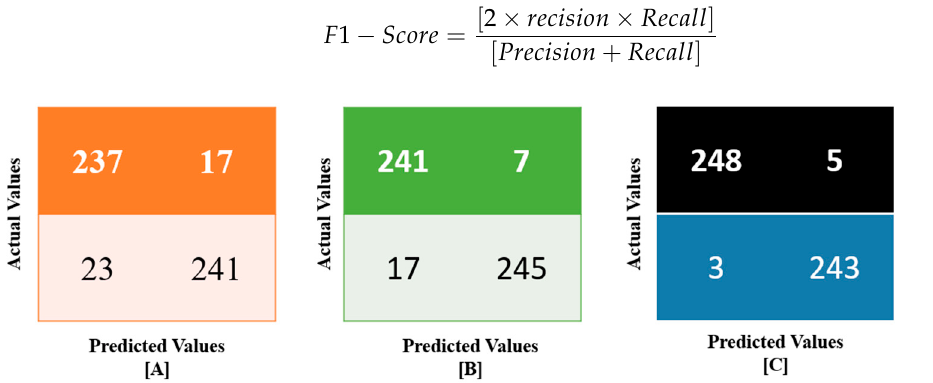
Figure 3. Confusion matrices obtained for various learning models ( A ) ANN ( B ) CNN ( C ) RNN.